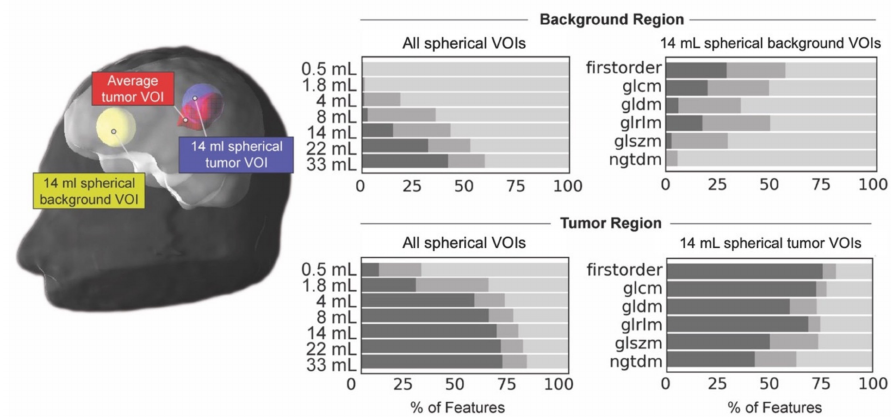
Figure 3. Comparison of feature repeatability for background and tumor regions. Left: Spherical tumor volumes-of-interest (VOIs) were positioned in the healthy background (yellow spherical background VOI) and the tumor volume centered on the maximum uptake (blue spherical tumor VOI). The average tumor VOI, used for most of the experiments, is presented in red. Right: Upper panels represent feature repeatability for the background region. The lower panels represent feature repeatability for the tumor region. Left panels show the percentage of feature repeatability for individual volumes. Right panels present the percentage of feature repeatability of individual feature groups for the 14 mL volume only. Features were considered repeatable if the lower and upper limits of the intraclass correlation coefficient 95% confidence interval were in the range of 0.91 to 1.00 (+, dark gray), not repeatable if between 0.01 and 0.90 ( − , light gray), and moderately repeatable if the upper limit was between 0.91 and 1.00 and the lower limit was in the range of 0.75 to 1.00 (o, medium gray). glcm = gray level co-occurrence matrix; gldm = gray level dependence matrix; glrlm = gray level run length matrix; glszm = gray level size zone matrix; ngtdm = neighboring gray tone difference matrix.